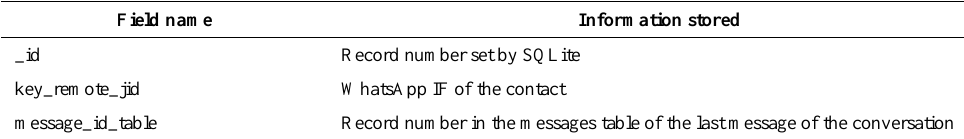
Table 10. Structure of the chat database